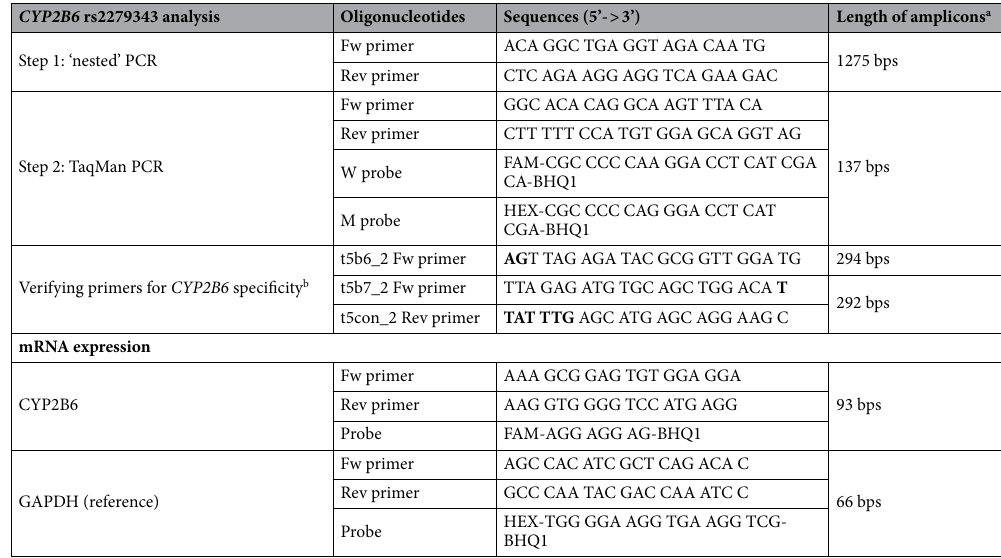
Table 1. Oligonucleotide sequences for the CYP2B6 rs2279343 SNV analysis and CYP2B6 mRNA expression quantification. Fw forward, Rev reverse, W wild, M mutant, FAM, HEX fluorophores, BHQ1 quencher. a Length of amplicons were determined by NCBI Primer Blast. b Sequences of verifying primers based on Jacob et al. 45 with slight modifications (in